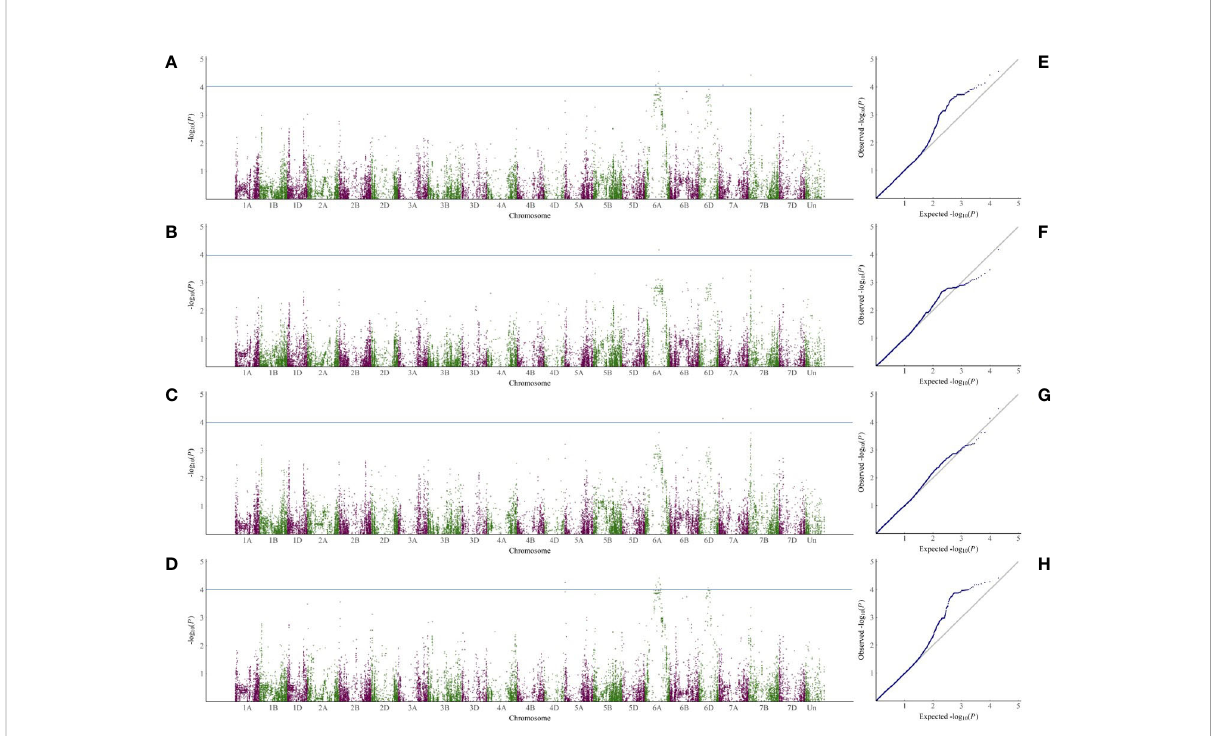
FIGURE 2 GWAS analysis of SNP loci related to sharp eyespot resistance in the three years. (A – D) , Manhattan plots of SNPs related to sharp eyespot resistance on 21 wheat chromosomes in three years and mean of three years. The x-axis and y-axis represent the genomic coordinates and LOD score for each SNP, respectively. (E – H) , Quantile-quantile (Q-Q) plots for the GWAS data in 2018 (E) , 2019 (F) , 2020 (G) and mean of three years (H) .